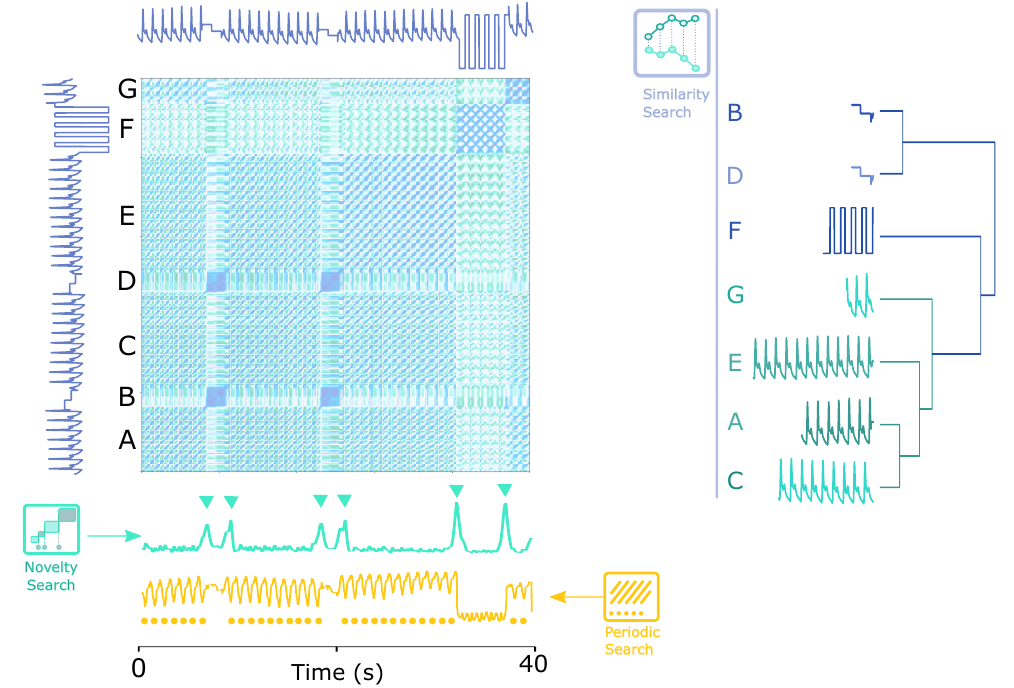
Figure 1. A visual structural description of functions on a time series for retrieving relevant events, segmenting, and associating the previously segmented subsequences based on the feature-based SSM. ( Left ): an Arterial Blood Pressure (ABP) signal’s SSM representing the pairwise similarity between subsequences, where the “novelty search” signal in green below the matrix demonstrates the novelty function and the “periodic search” signal in orange depicts the similarity function; ( right ): the clustering procedure of the novelty function-based segmented subsequences according to their similarity values in the